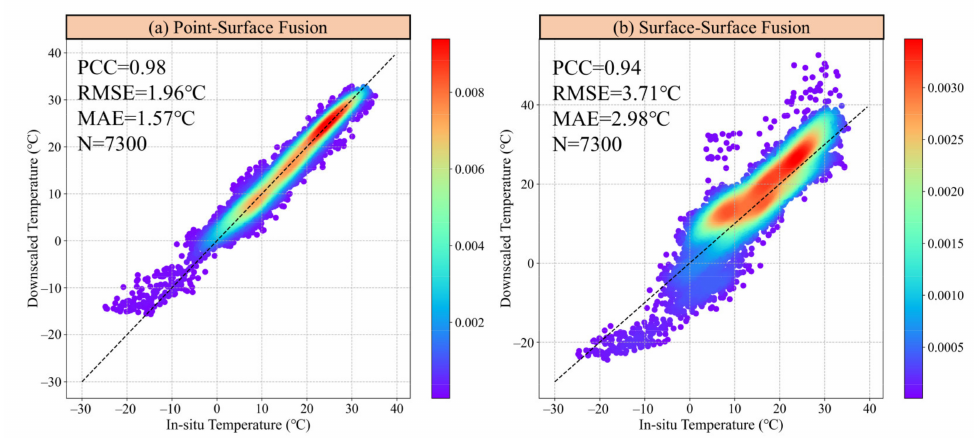
Figure 15. The scatter density plots for 20 validation stations based on point-surface data fusion ( a ) and surface-surface data fusion ( b